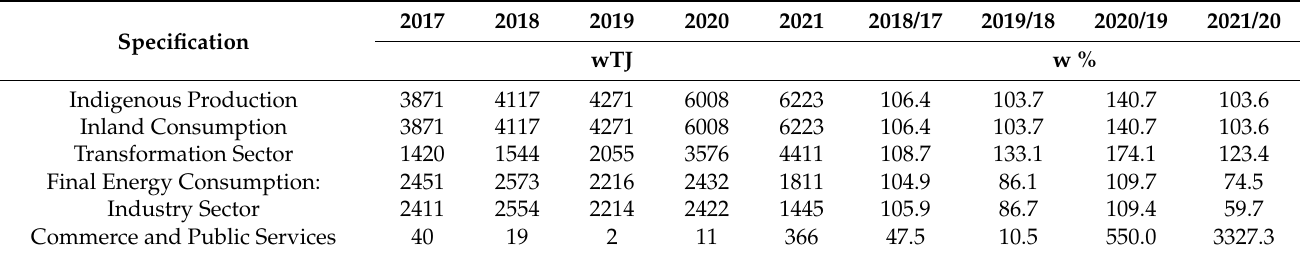
Table 1. The balance of renewable energy commodities in the years 2017–2021 (renewable munici- pal waste).